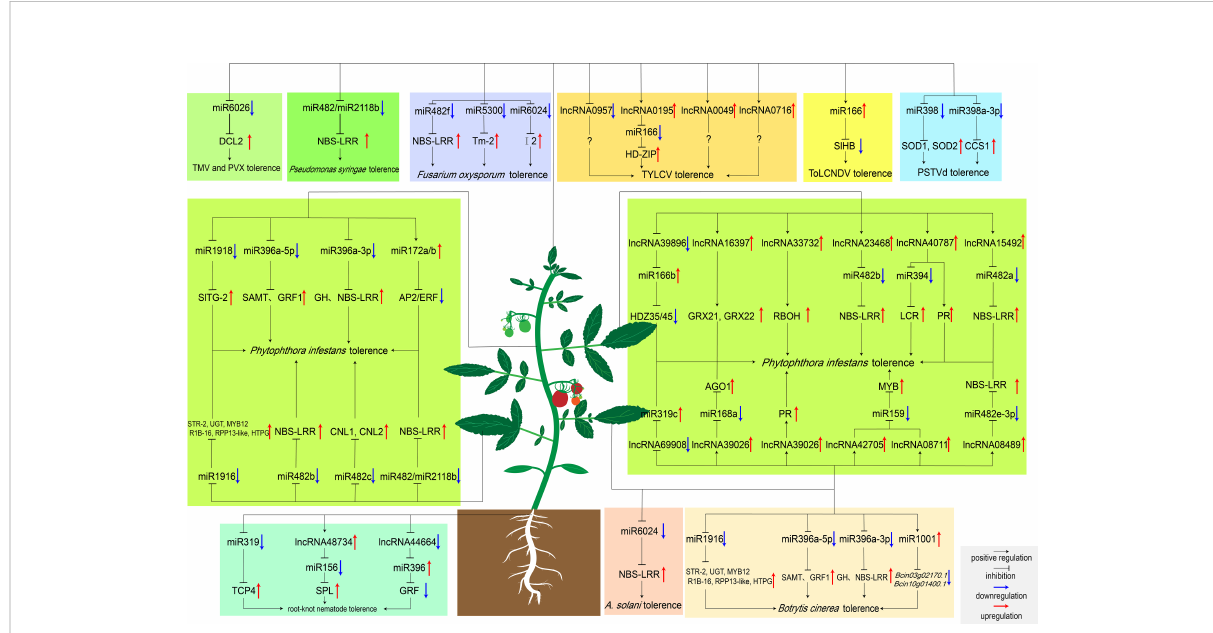
FIGURE 2 MiRNAs and lncRNAs regulate tomato response to biotic stresses. Boxes with different colors represent pathogen species regulated by ncRNAs. Particularly, Bcin03g02170.1 and Bcin10g01400.1 encode the ATP-dependent metallopeptidase and cysteine-type endopeptidase in B cinerea , respectively. MiR1001 reduces the virulence of B cinerea by repressing the expression of these two genes (Meng et al.,